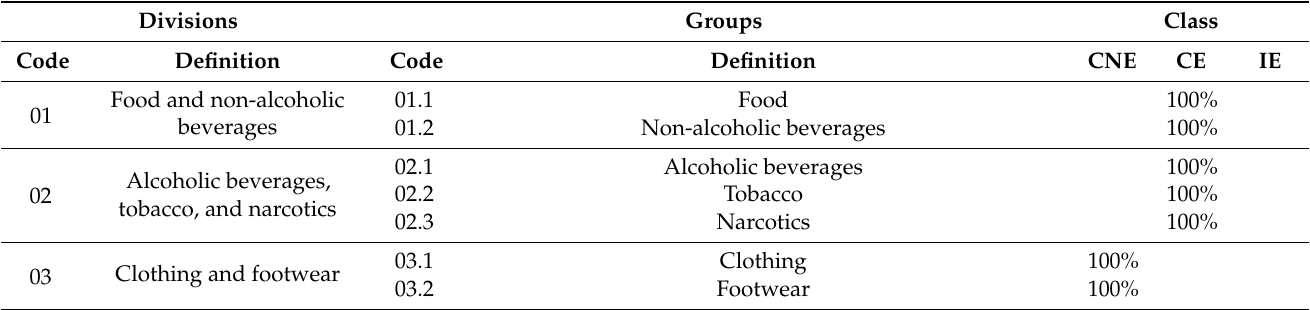
Table A1. Reclassification of the final consumption of households (COICOP). (Adapted from